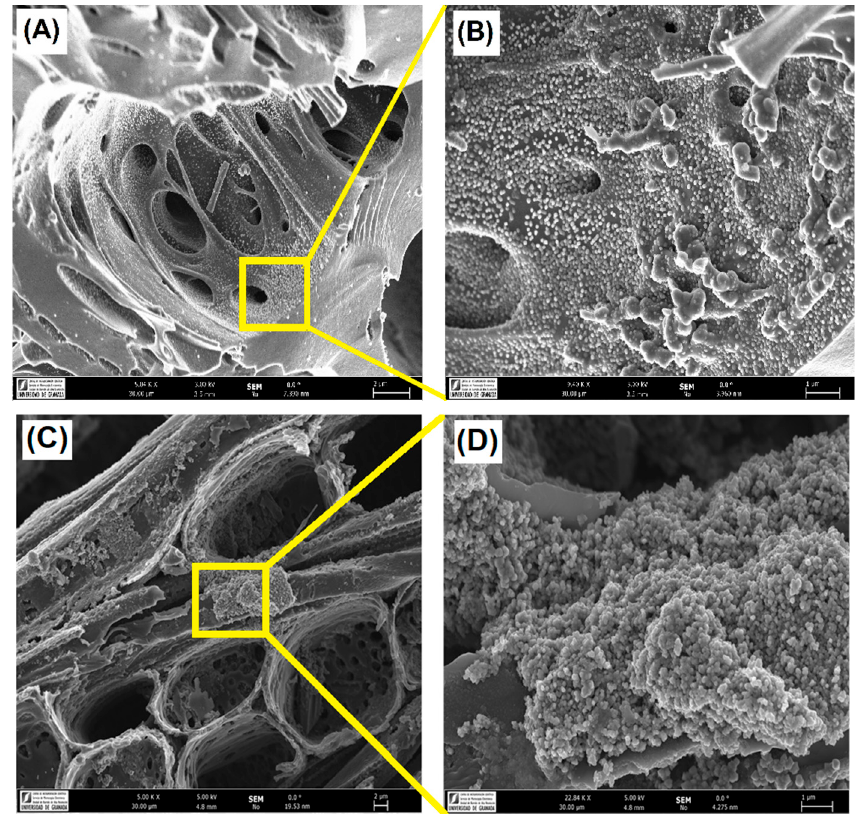
Figure 4. Morphology of: ( A ) OSC-AC-Fe ( C ) and SDC-AC-Fe; and ( B,D ) detail of Fe-nanoparticles coating the carbon surface.